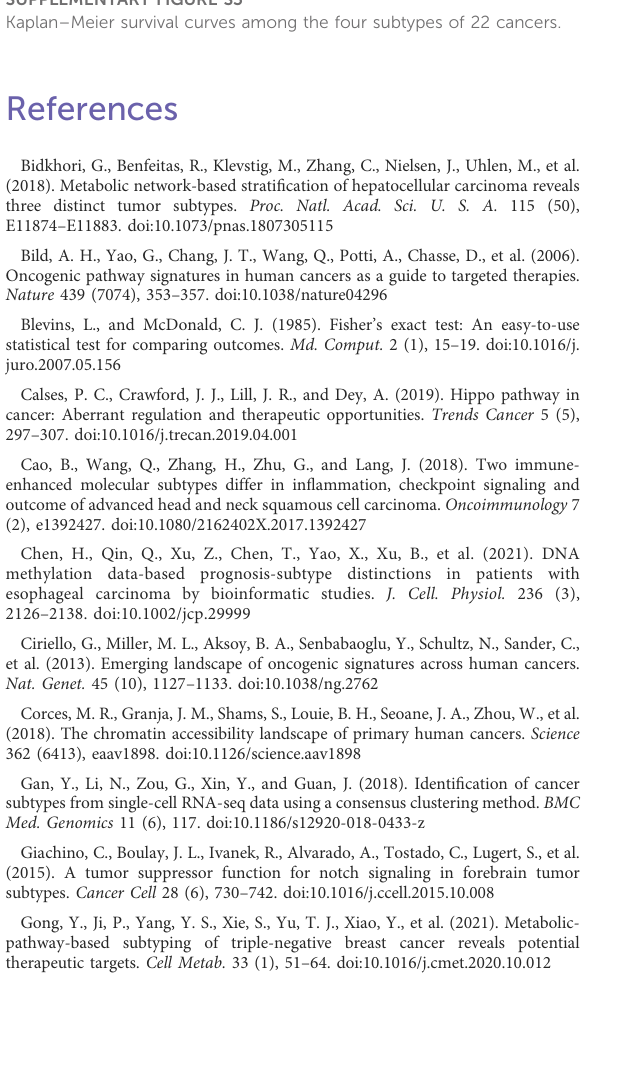
SUPPLEMENTARY FIGURE S7 Interactions of genes in the WNT pathway and fold change values of four subtypes of genes. SUPPLEMENTARY FIGURE S8 In fi ltration of immune cells in MCP and TIMER in four subtypes. SUPPLEMENTARY TABLE S1 TCGA dataset. SUPPLEMENTARY TABLE S2 Differentially expressed genes across the four subtypes. SUPPLEMENTARY TABLE S3 Differentially methylated